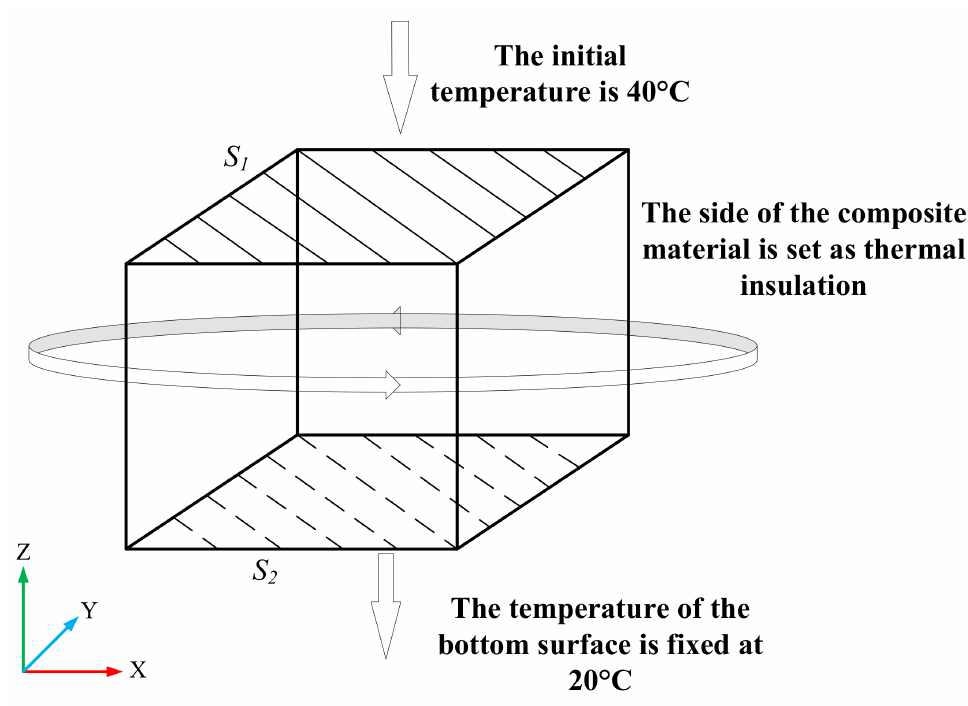
Figure 10. Model boundary